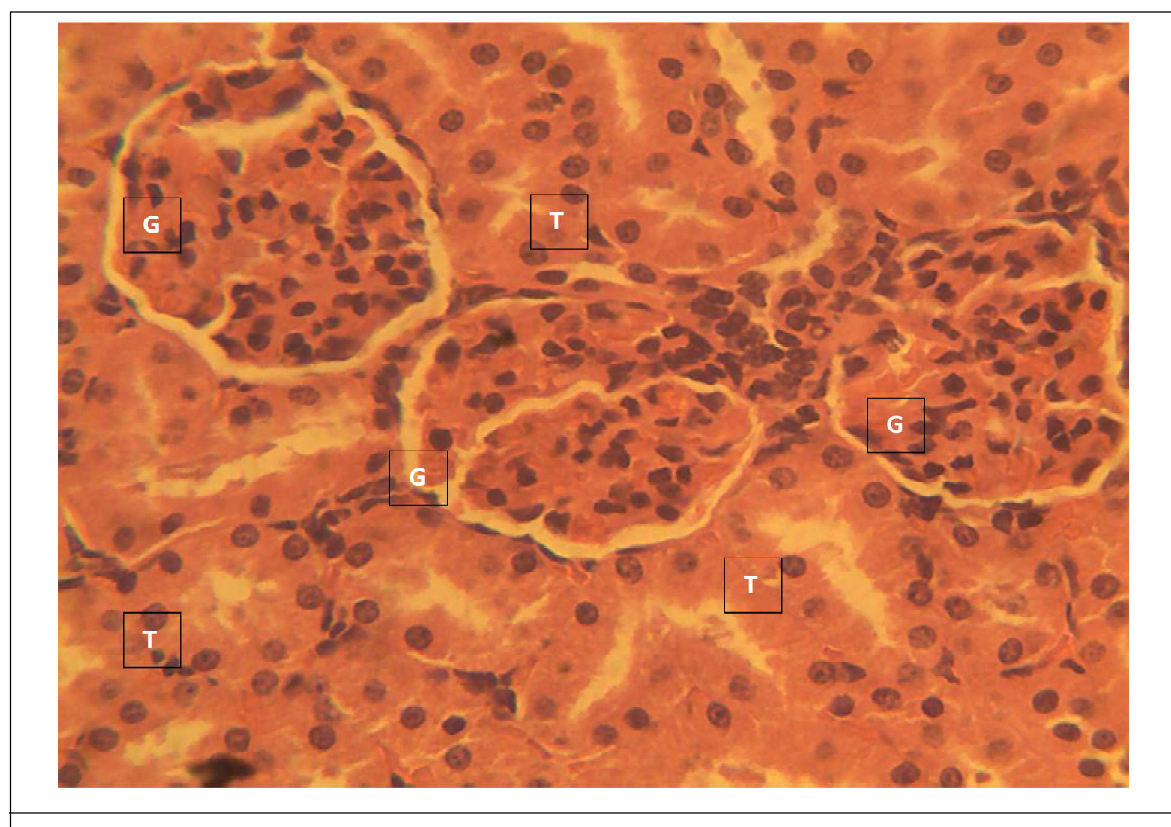
Plate 16: Control group of the female kidney exposed to no extract